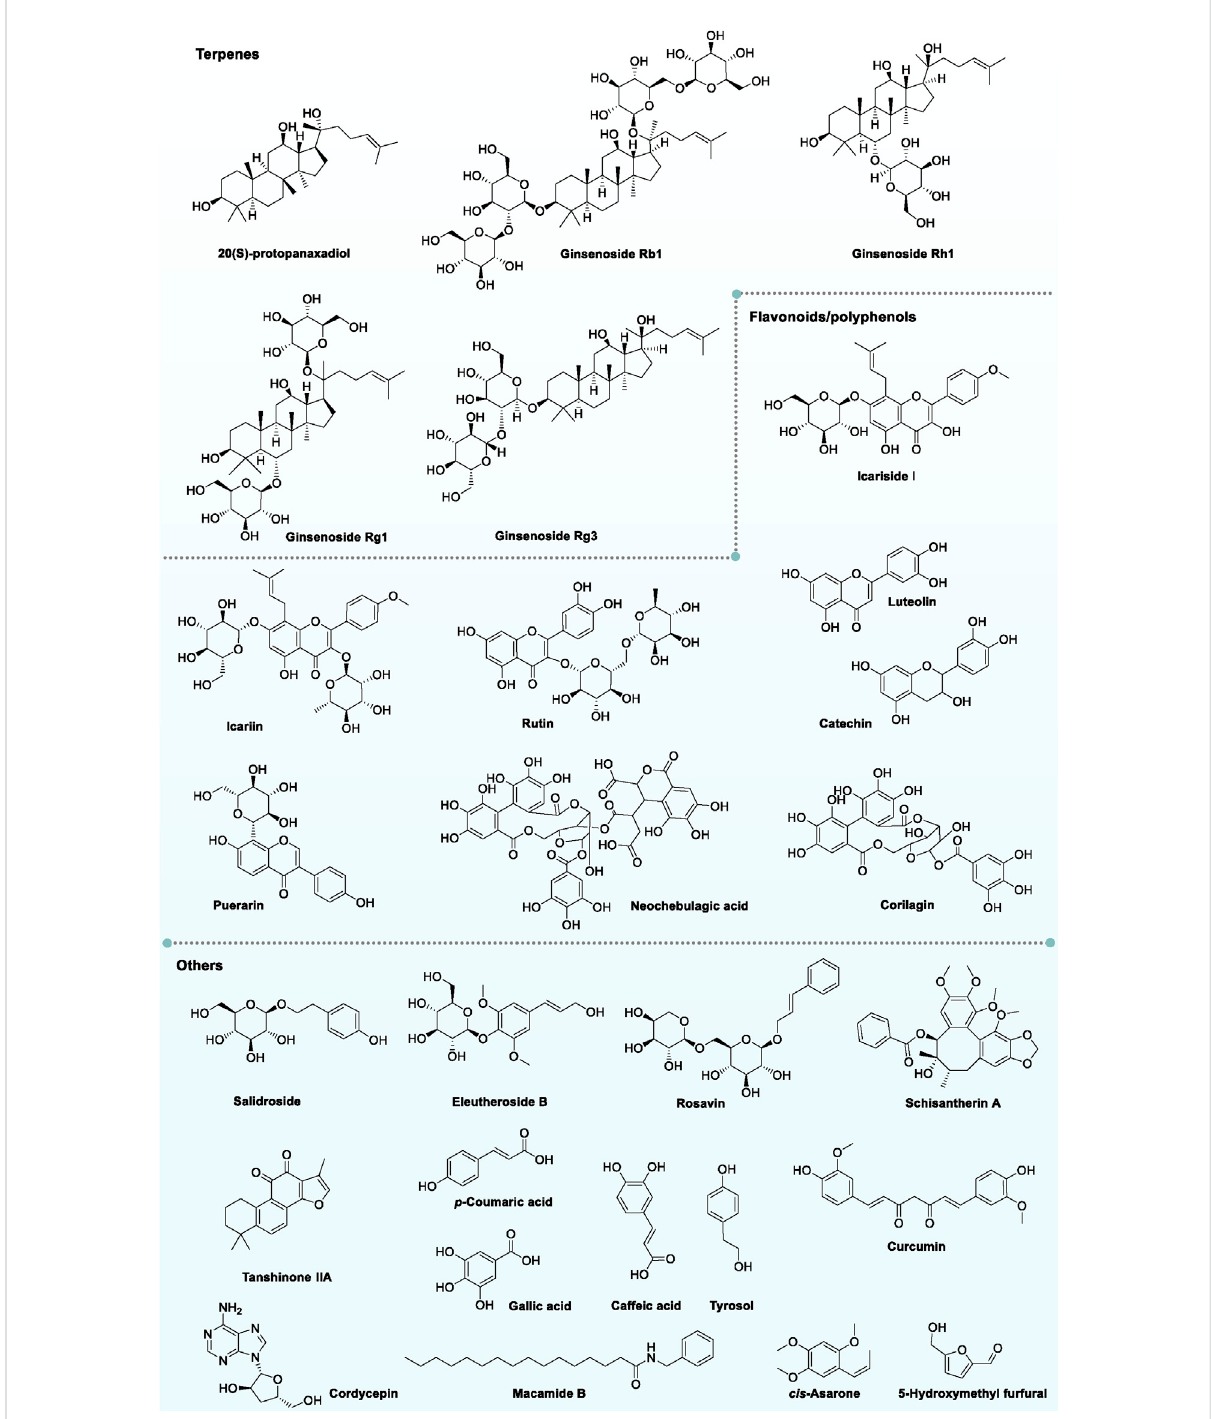
FIGURE 2 Representative chemical structures of TCMs with relieving effect on exercise-induced